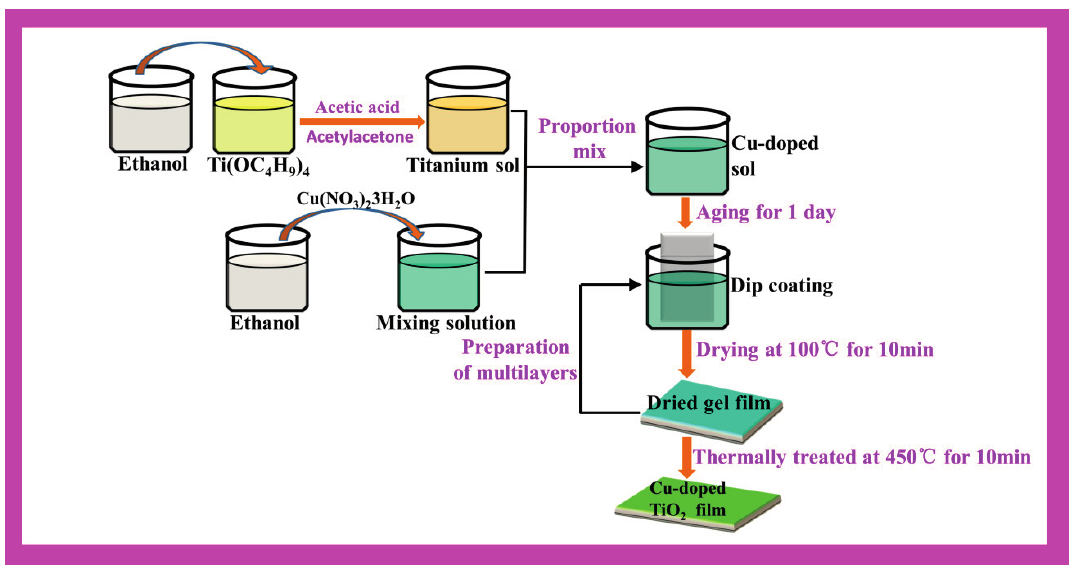
Figure 1. The detailed process of preparation of the Cu-doped TiO 2 thin